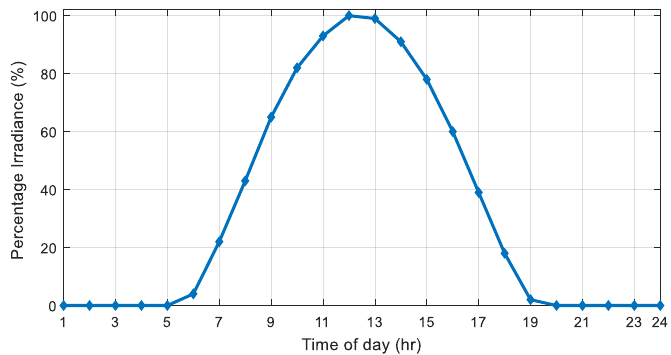
Figure A2. Building efficiencies when adopting the AC or DC systems. The loading of DC-AC converters and DC-DC converters are the decisive factors in the system’s efficiency. Figure A2 shows that the building efficiency of the AC home is almost constant, whereas the DC home efficiency varies due to a varying load, hence converter efficiencies. In the case of the AC home, converters are required for ‘D’ category loads only; ‘A’ and ‘I’ category loads require no converter for their operation. Moreover, there is no significant drop/rise in the power consumption of ‘D’ category loads, which may cause notable efficiency variation of the AC-DC converter, making